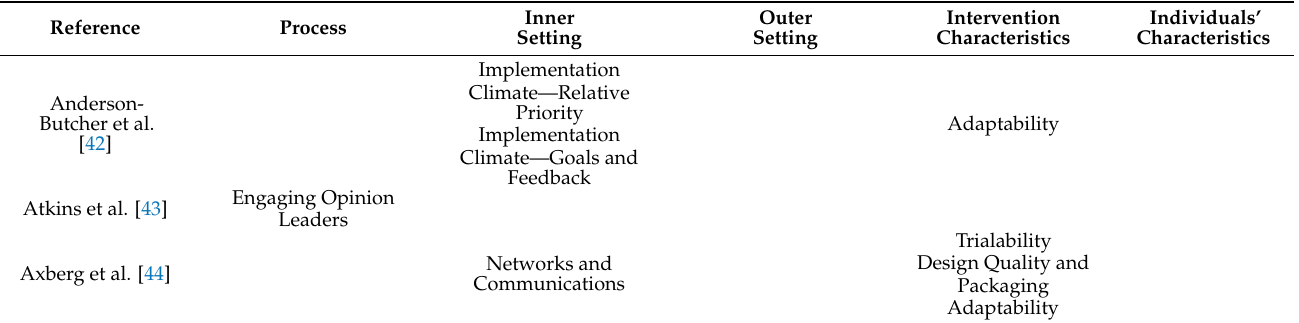
Table 3. Implementation-related information per